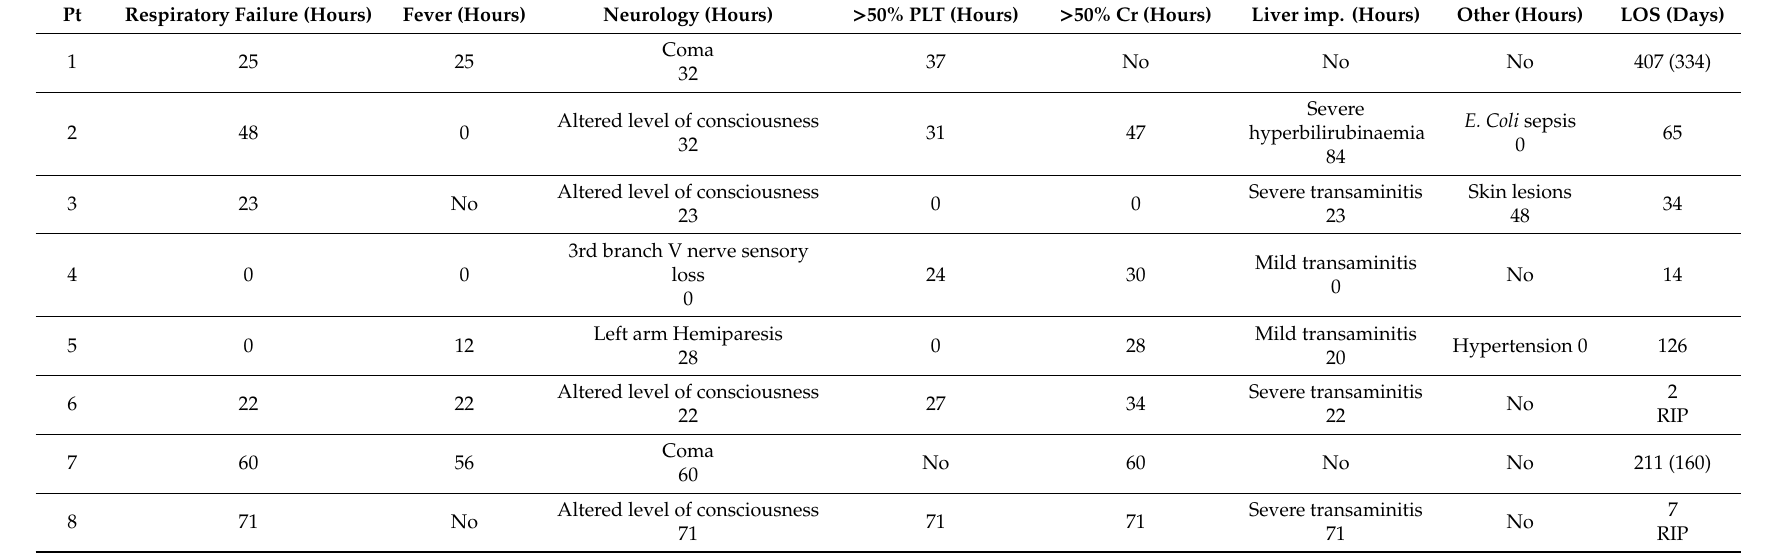
Table 2. Clinical features at onset and evolution (hours from presentation) during